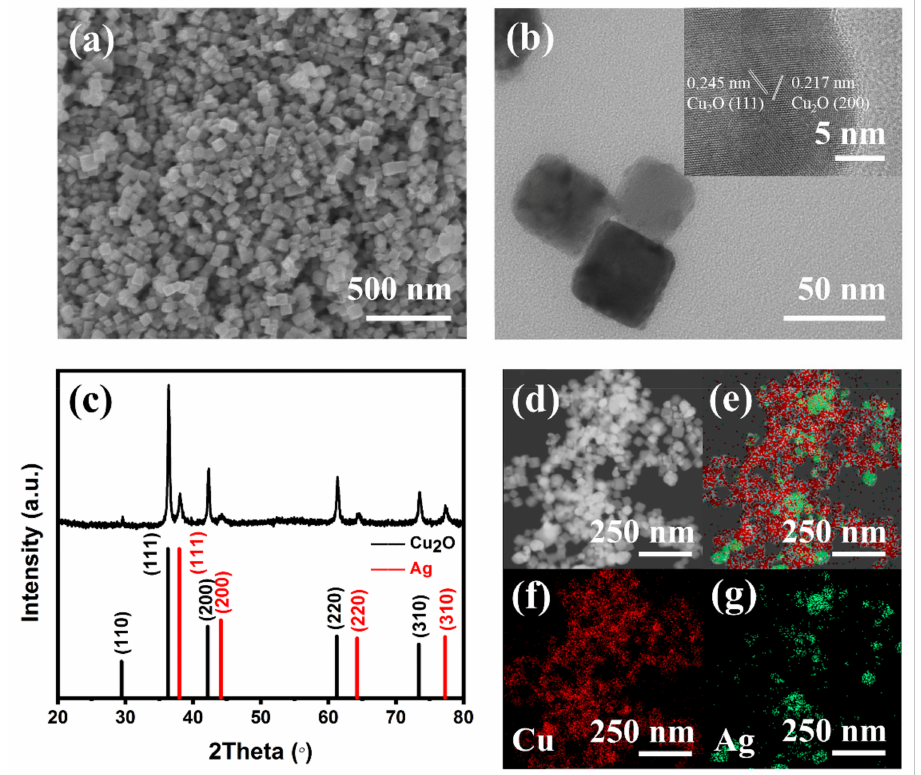
Figure 1. ( a ) SEM image of Cu 2 O-Ag nanocubes. ( b ) TEM and (inset) HRTEM images of Cu 2 O-Ag nanocubes. ( c ) XRD pattern of Cu 2 O-Ag nanocubes. ( d – g ) HRTEM-EDS elemental mapping of Cu 2 O-Ag nanocubes, identifying homogeneously distributed ( f ) Cu and ( g )